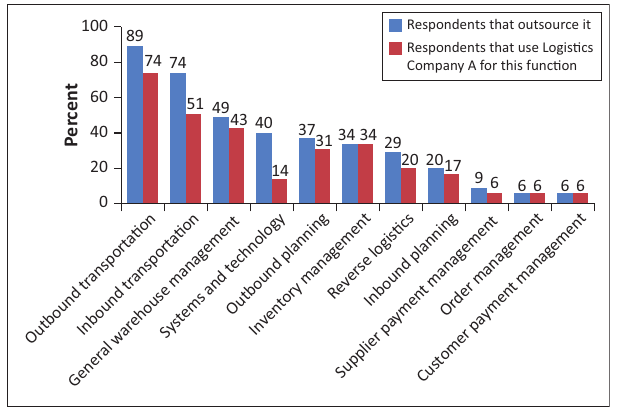
of logistics company A.